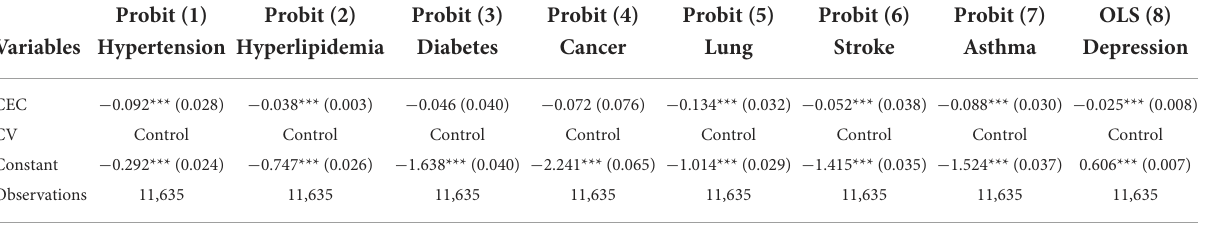
TABLE 8 The regression results of CEC and eight different common